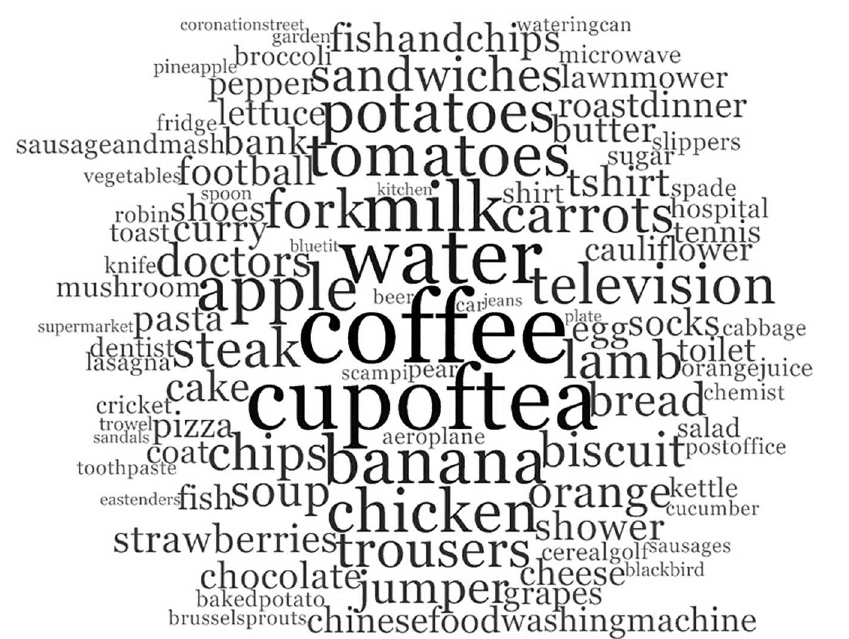
Fig 2. Words chosen with the